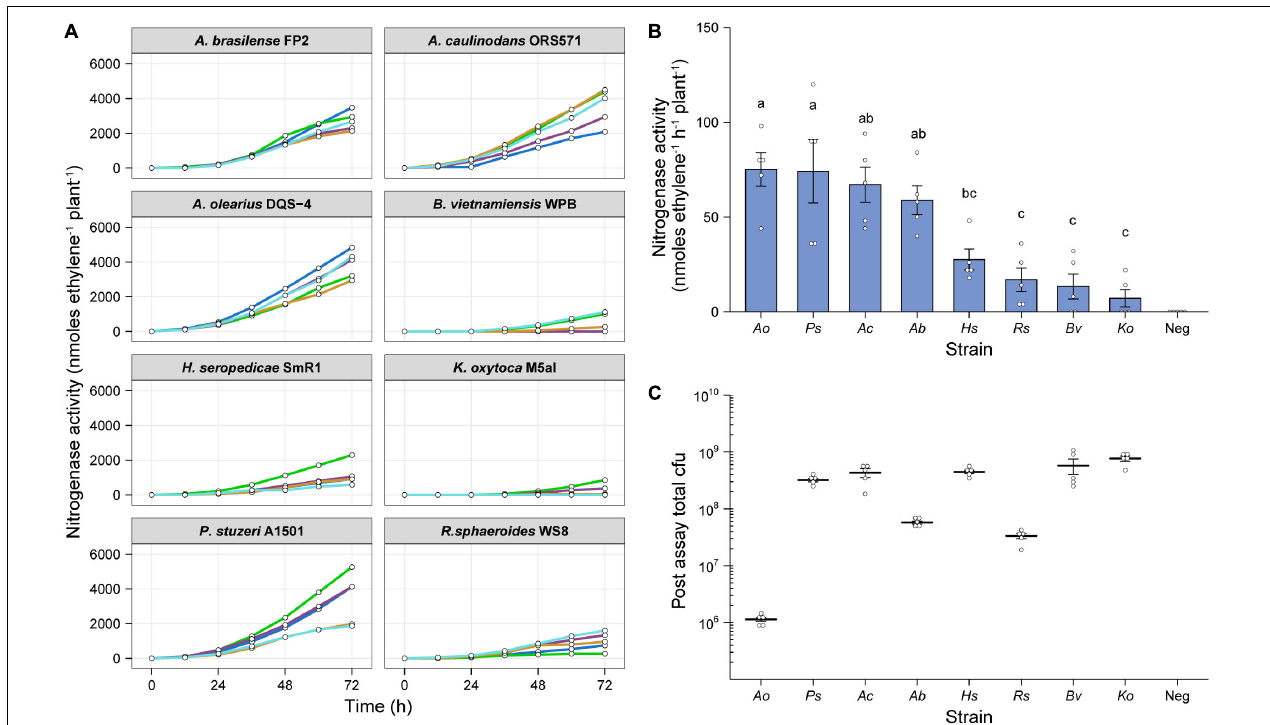
FIGURE 4 | In situ ARA of eight model diazotrohic bacteria. Assays were set up as described in Figure 2 . Two milliliters of an OD 600 nm 0.01 suspension of bacteria were used for inoculation and C 2 H 4 production was measured at 12-h intervals over 72-h. (A) C 2 H 4 production was measured for five biological replicates of eight genetically diverse diazotrophic bacteria inoculated gnotobiotically onto barley. (B) The mean ± SEM (error bars) rates of nitrogenase activity between 48-h and 62-h were calculated for the eight model diazotrophs. ANOVA and LSD tests with Bonferroni adjusted P -values were used to compare means. The negative uninoculated control omitted from statistical tests. Matching letters depict treatments that are not significantly different ( P > 0.05) from each other but are significantly different ( P < 0.05) from treatments with a distinct letter. (C) Mean ± SEM (error bars) of total cfu present in the assay systems as determined by viable counts after 72-h. No cfu were observed for the uninoculated control. Note that the low total cfu count for Azoarcus olerarius DQS-4 may be a result of poor viability of the strain upon re-isolation from the plant, as has been reported previously (Hurek et al., 2002).